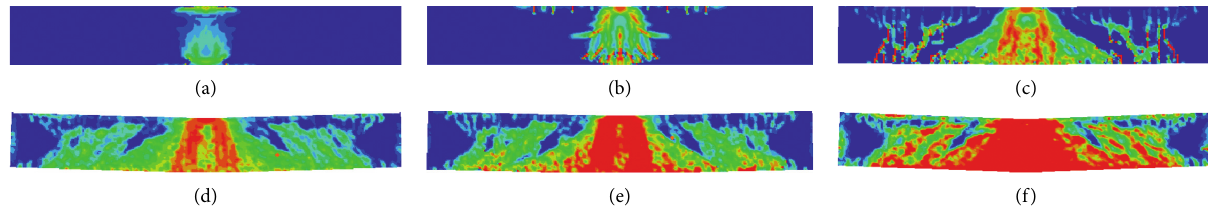
Figure 18: Crack development diagram of the L16-2 beam: (a) 1ms, (b) 1.5ms, (c) 5 ms, (d) 8ms, (e) 10ms, (f) 15ms.